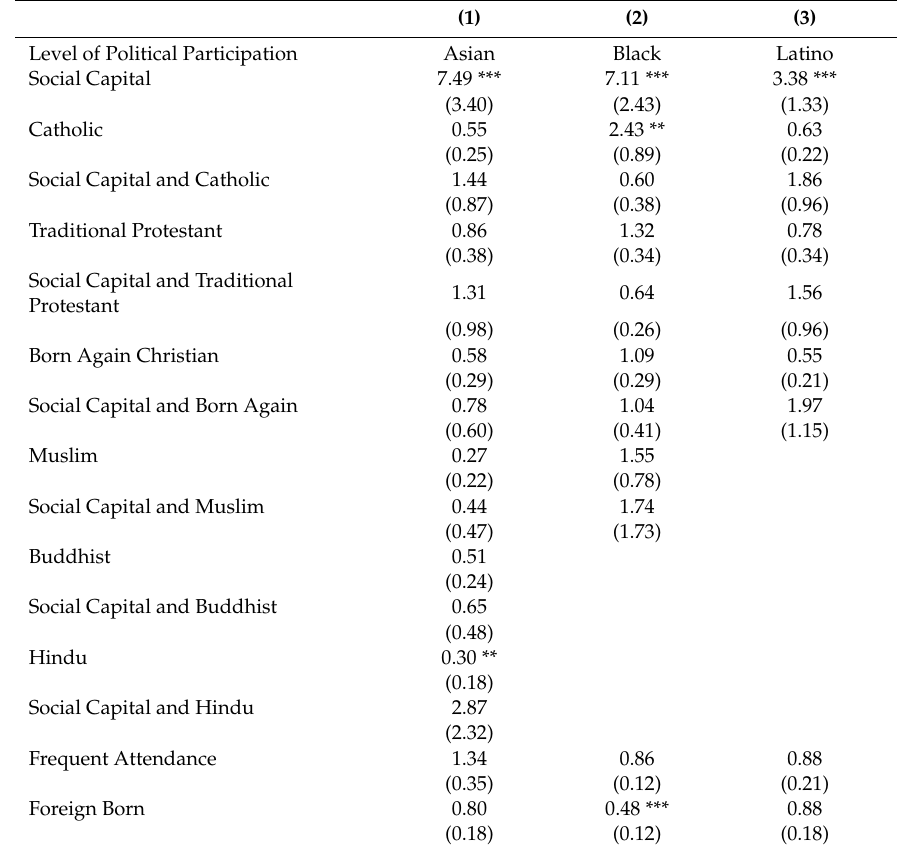
Table 6. Odds ratios of the e ff ect of social capital and tradition on political participation controlling for frequent attendance (with robust standard